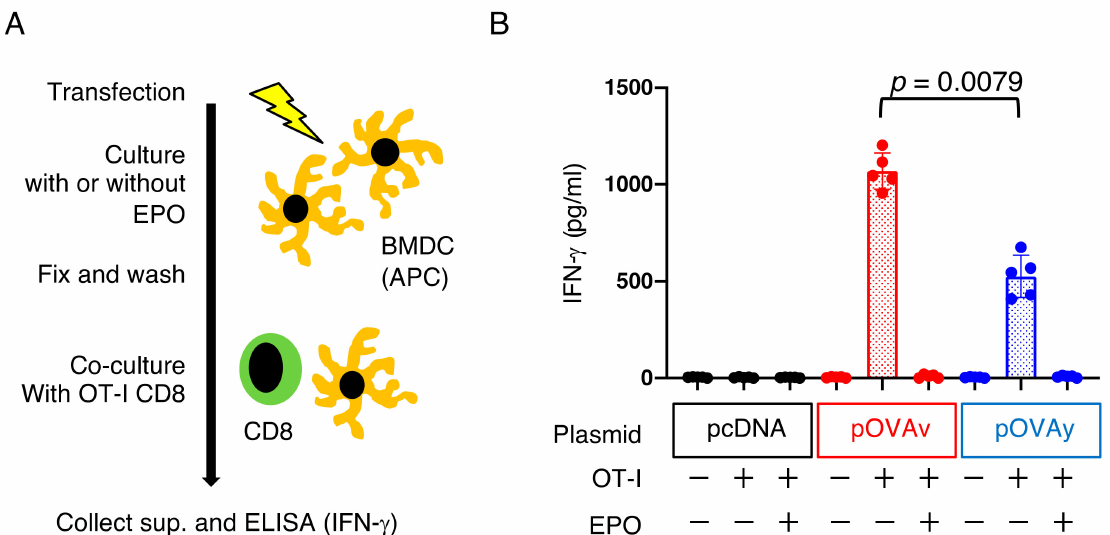
Figure 4. pOVAv induced higher levels of antigen presentation than pOVAy in vitro. ( A ) Protocol of endogenous antigen presentation assay. BMDCs were transfected with plasmid DNA and incubated for 5 h with or without proteasome inhibitor, and then fixed and co-cultured with OVA-specific CD8 + T cells from OT-I mice. The culture supernatants were collected to measure the levels of IFN- γ (see Materials and Methods). ( B ) IFN- γ production of the indicated experimental group. Data are representative of results from two independent experiments with similar results ( n =